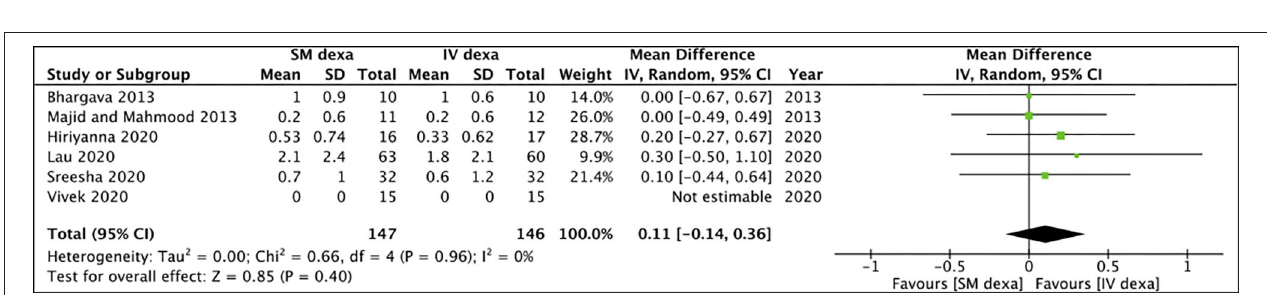
FIGURE 3 | Meta-analysis of late pain between SM and IV dexamethasone (dexa) for third molar surgeries.